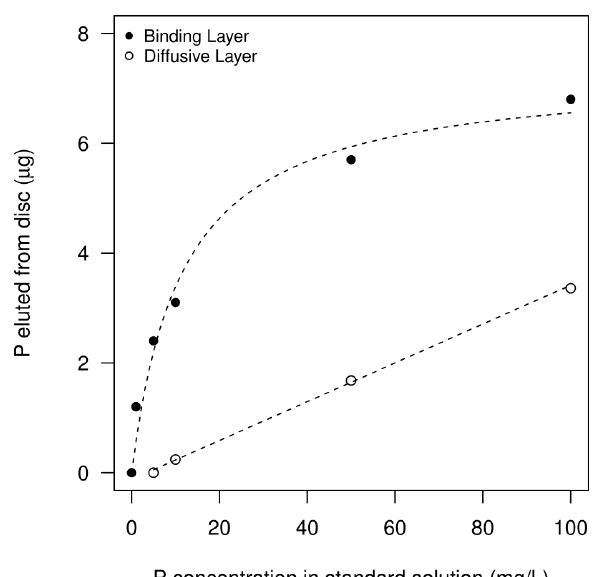
Figure 1. P eluted from a binding layer and a diffusive layer of diffusive gradients in thin films (DGT) devices following an exposure of 24 h to standard solutions with increasing phosphorus (P) concentrations and after the elution of the layers in 1 M HNO 3 . The dotted lines indicate the Michaelis-Menten-like P uptake of the binding gel (with a calculated maximum capacity of 7.3 µg (P)) and the linear relation of the diffusion of P into the diffusive layer at increasing P concentrations.